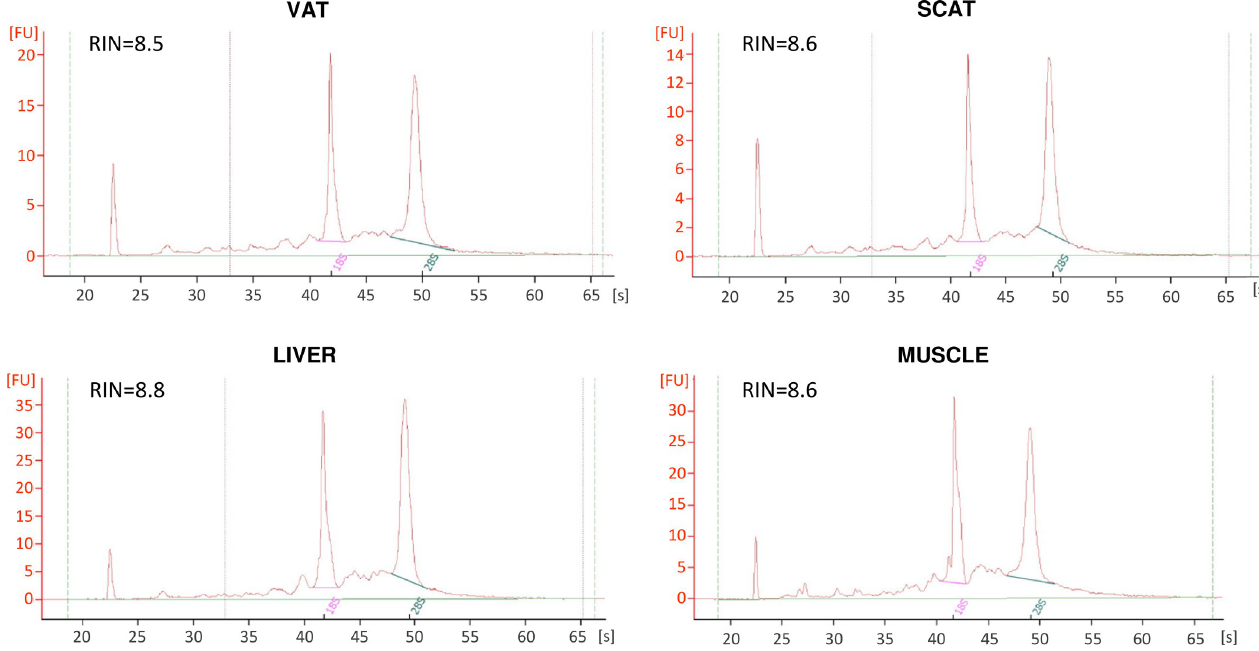
Fig 2. Electropherograms of RNA samples obtained for the four tissue types. Electropherograms were obtained on RNA samples using 2100 Bioanalyser and RNA 6000 Nano chips. Typical electrophoretic traces and RIN were shown for VAT, SCAT, liver, and muscle extracted in 2016. SCAT, sub–cutaneous adipose tissue; VAT, visceral adipose